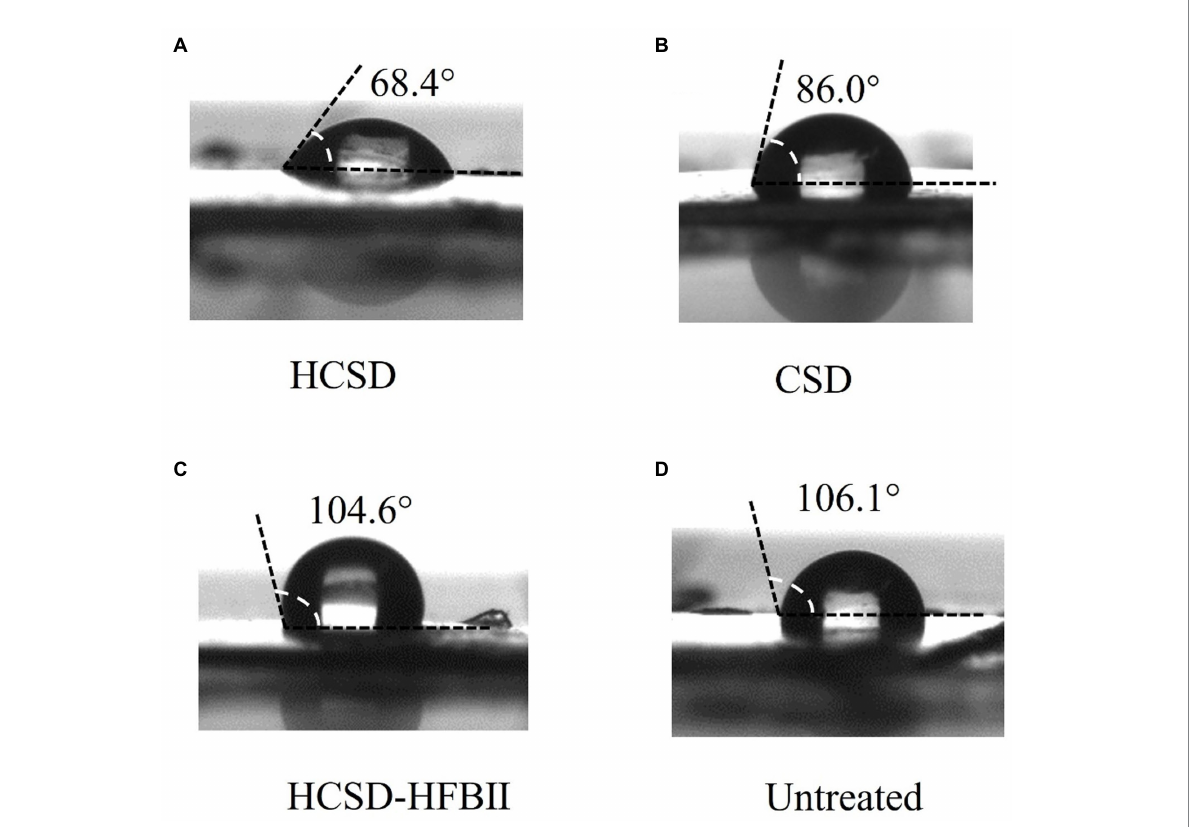
FIGURE 4 Water contact angle (WCA) of pretreated PET surface by E. coli harboring plasmid pET30a (+): HCSD (A) , pET30a (+): CSD (B) and pET30a (+): HCSD-HFBII (C) and untreated (D)